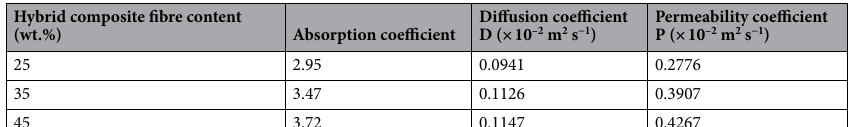
Hybrid composite fibre content